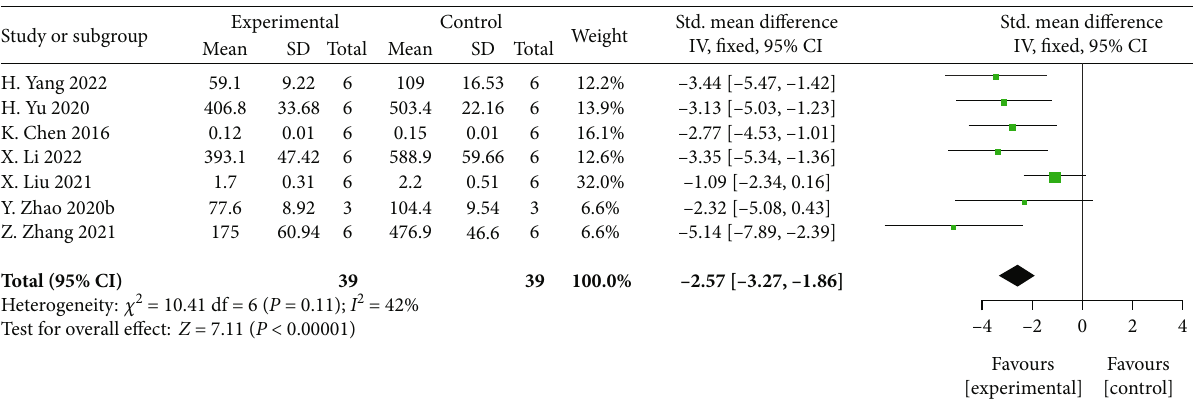
Figure 8: The forest plot: e ff ects of MSCs-derived sEVs for reduced the expression of proin fl ammatory factor IL-1 β compared with control group.